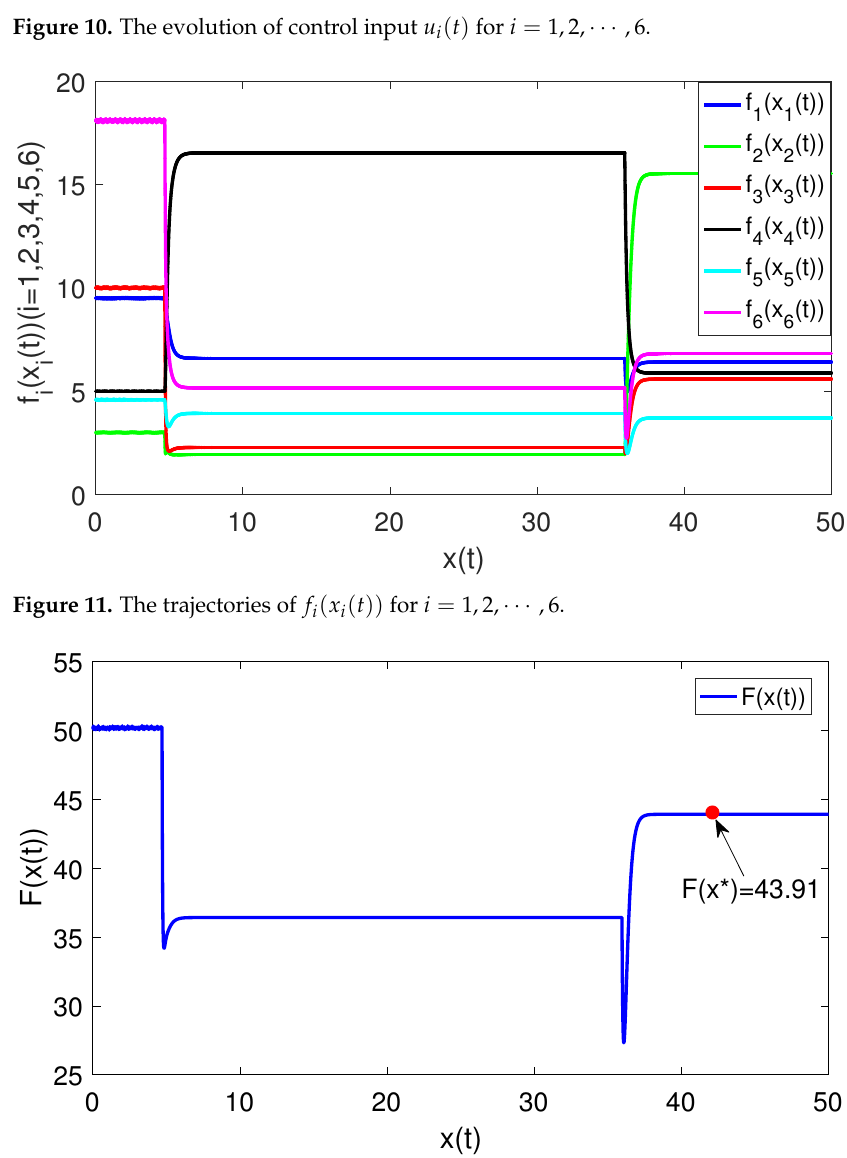
Figure 12. The trajectory of F ( x ( t ))